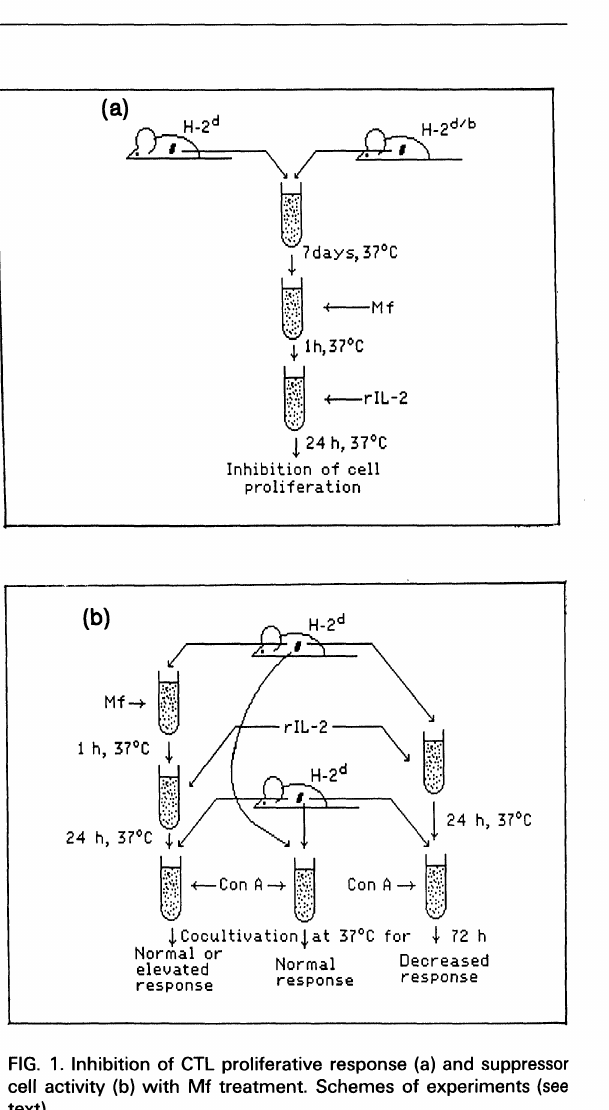
FIG. 1. Inhibition of CTL proliferative response (a) and suppressor cell activity (b) with Mf treatment. Schemes of experiments (see